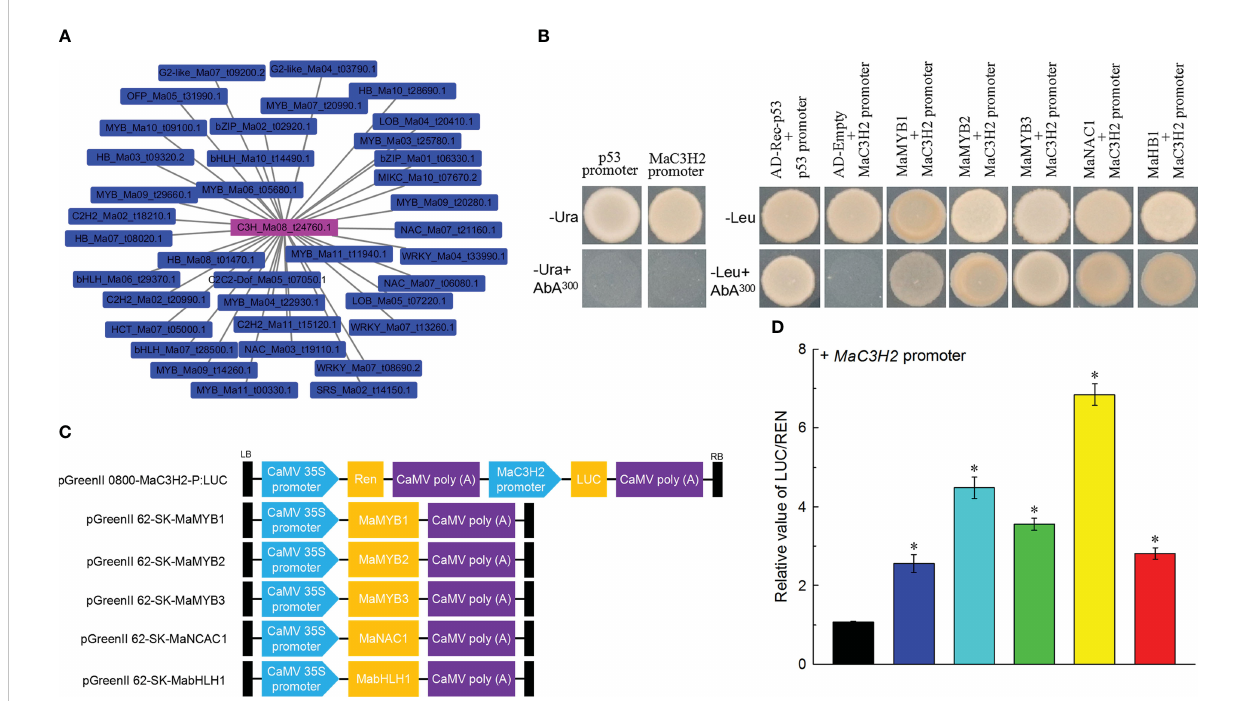
FIGURE 9 Identi fi cation of upstream regulatory transcription factors of MaC3H2. (A) Co-expression network of MaC3H2 by WGCNA. (B) Yeast one-hybrid assay of MaMYB1, MaMYB2, MaMYB3, MaNAC1 and MabHLH1 bind with MaC3H2 promoter. (C) Schematic diagrams of the effector and reporter constructs used for the dual LUC assay. (D) MaMYB1, MaMYB2, MaMYB3, MaNAC1 and MabHLH1 activate the MaC3H2 promoter in dual-luciferase assays. * Signi fi cant difference at P <